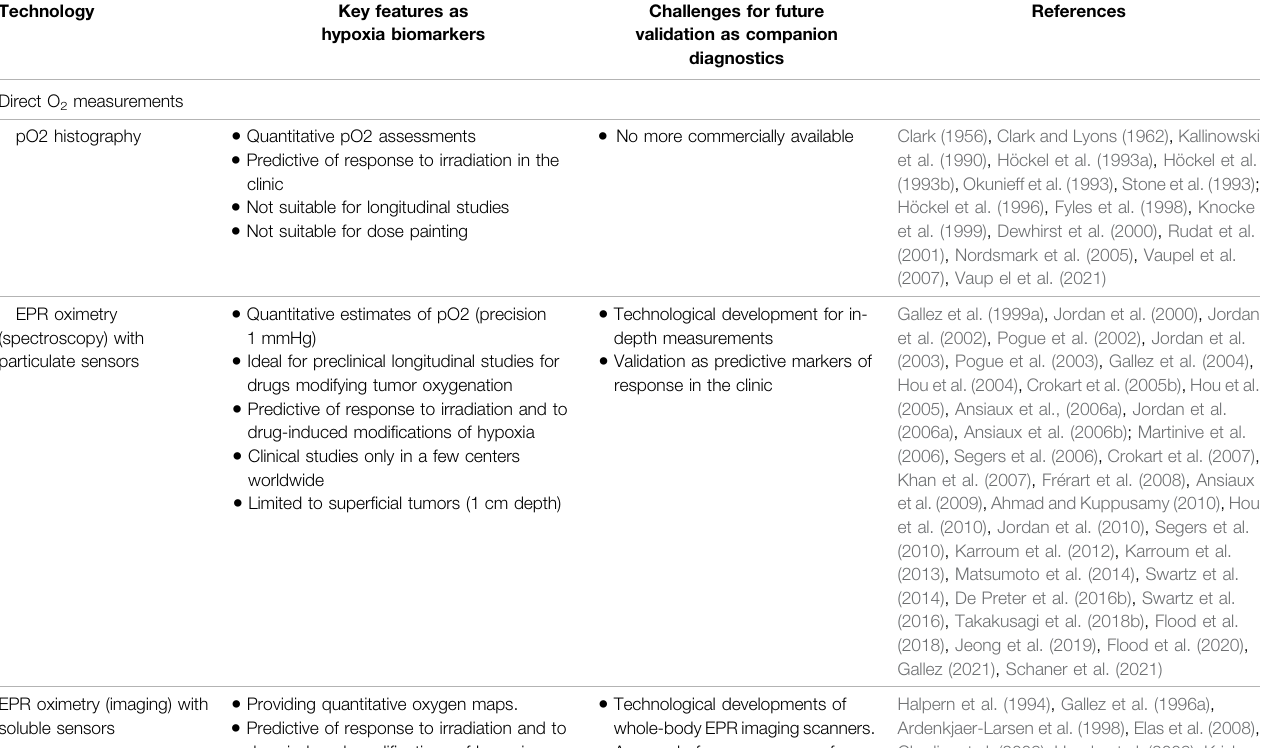
TABLE 1 | Key features of technologies for their use as hypoxia biomarkers and challenges for future validation as companion diagnostics.